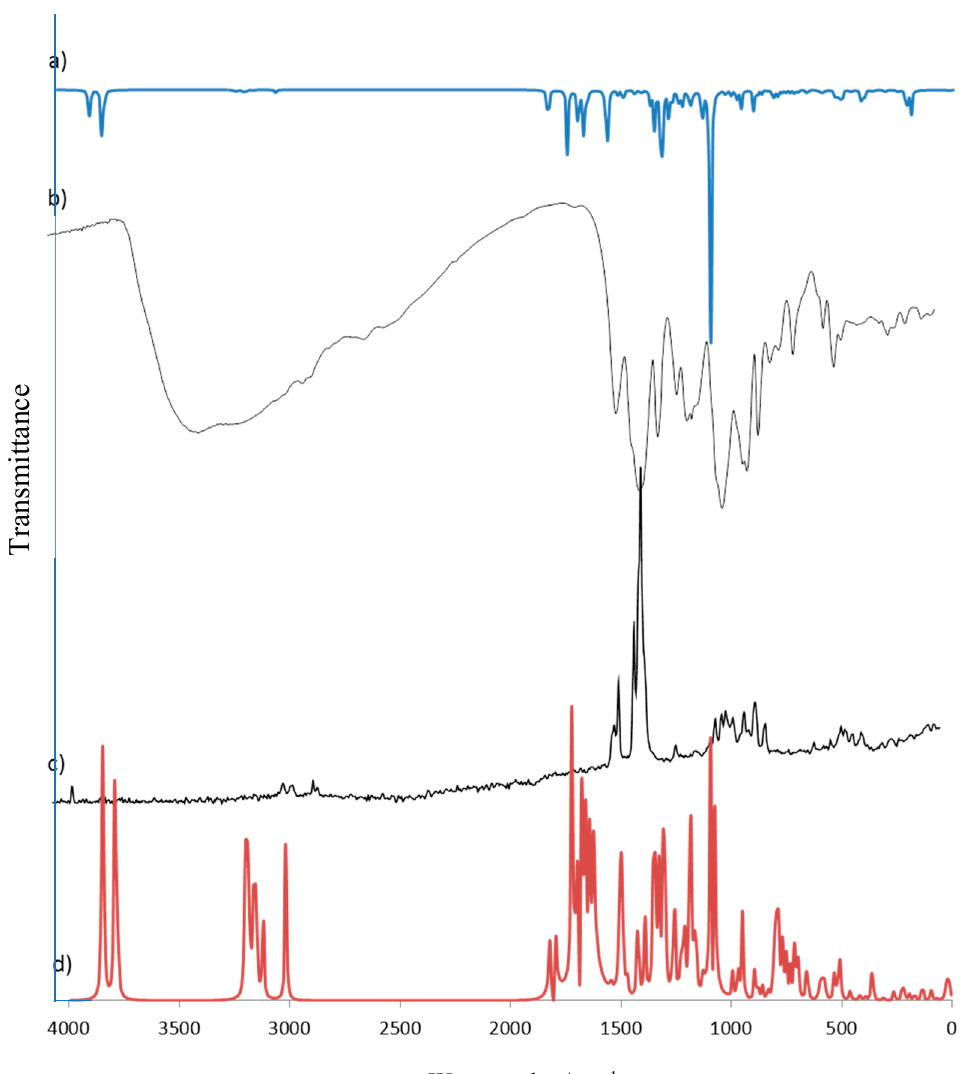
Figure 6. Experimental and calculated vibrational spectra of rosmarinic acid: FT − IR ( a , b ) and Raman ( c , d ).